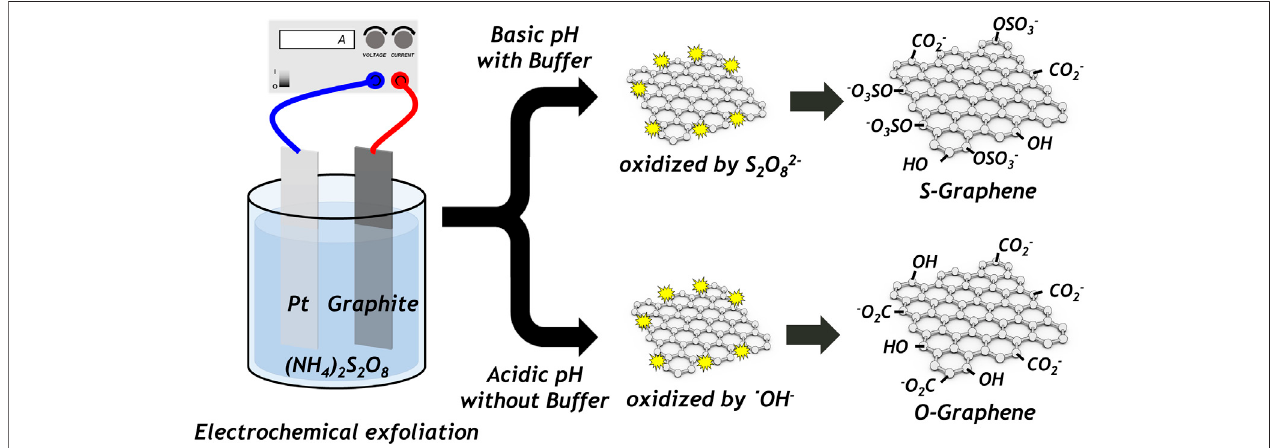
FIGURE 1 | Schematic of the electrochemical exfoliation of graphite with and without pH buffer.